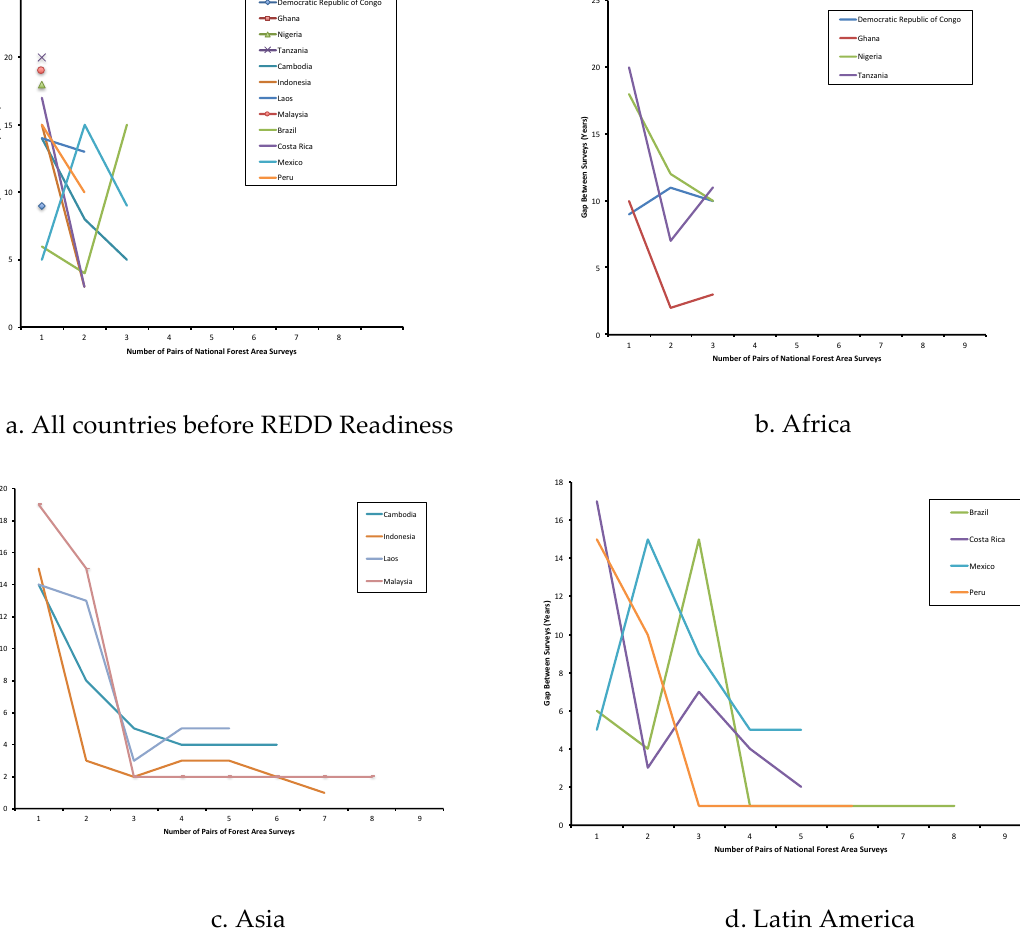
Figure 5. Frequencies of national forest area surveys in twelve tropical countries, showing the number of years between successive surveys: ( a ) before REDD + Readiness [38,80–82]; and afterwards in ( b ) Africa, ( c ) Asia and ( d ) Latin America [66–77].